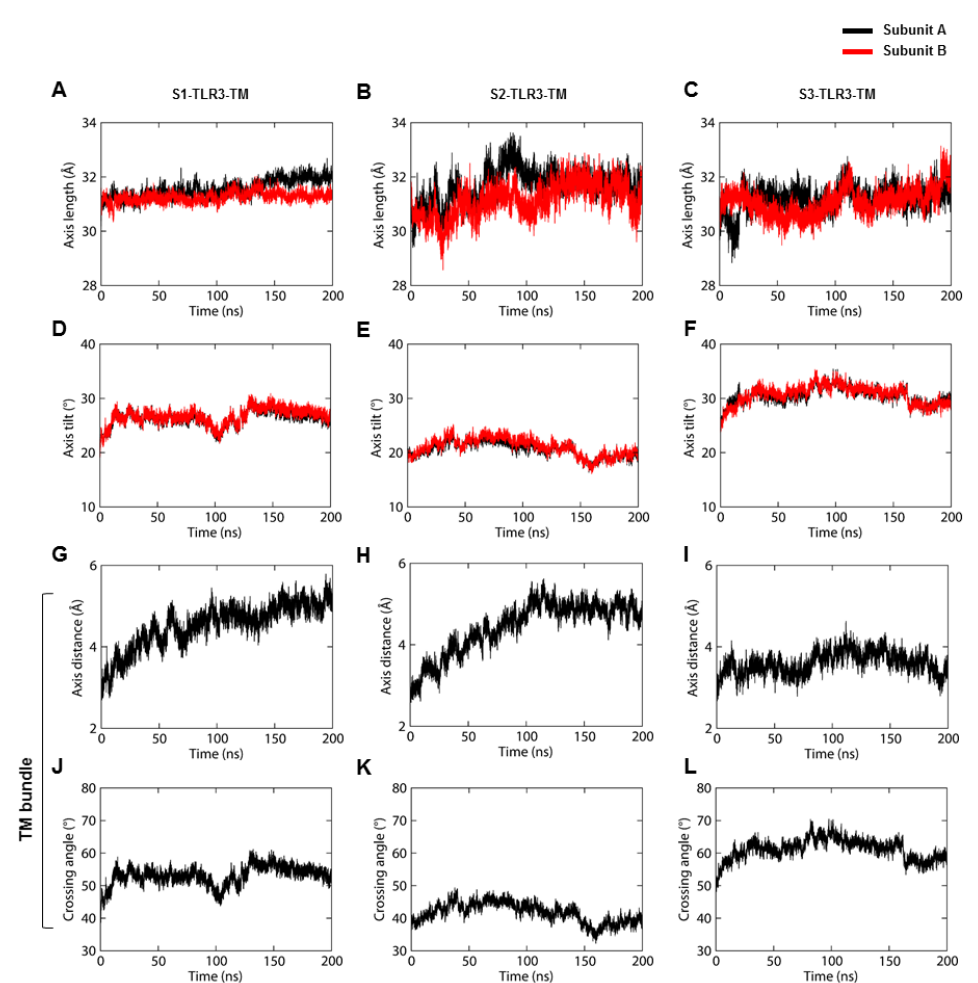
Figure 6. Helical properties of TM domains. ( A – C ) The length of the helical axis of the TM dimer. ( D – F ) The tilt angle of the TM helices with respect to the average angle of the helical axis. Subunits A and B are shown as black and red lines, respectively. ( G – I ) The distance between axis centers of individual TM domains. ( J – L ) Crossing angle of TM helices as a function of time. S1, S2, and S3 represent the second replicate of sets 1, 2, and 3, respectively.